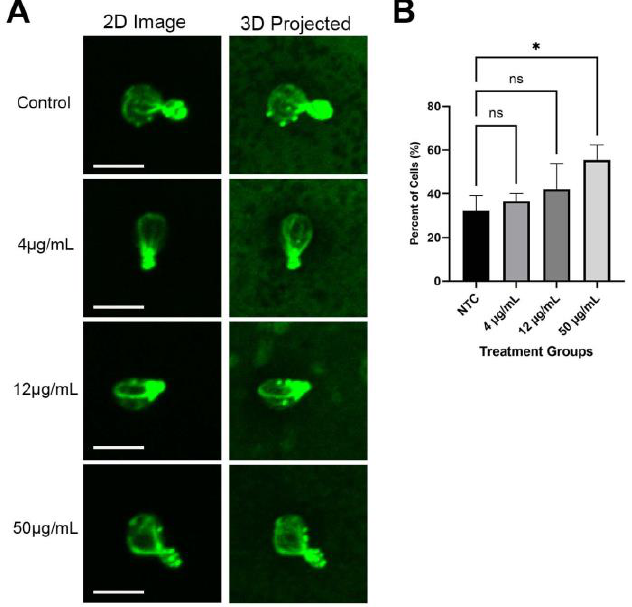
Figure 13. A recovery assay was performed where cells exposed to QDs were moved to a QD-free media for 3 h and the morphology of the actin cable was assessed. ( A ) Images of the actin cable when stained with Actistain 488 and visualized with the confocal microscope. The left column is a flat, 2D image taken at the mid-plane of cells when cells are in focus. The right column is the projected pictures from 3D images that allow the visualization of all cables inside yeast cells. Each row signifies images from a treatment group, in the top-down order: control, 4 µ g/mL, 12 µ g/mL, 25 µ g/mL, and 50 µ g/mL. The size bar is equivalent to 5 µ m. ( B ) The percentage of cells with abnormal actin cable was quantified and graphed. A total of 30 cells were used for each sample. * p < 0.05 .